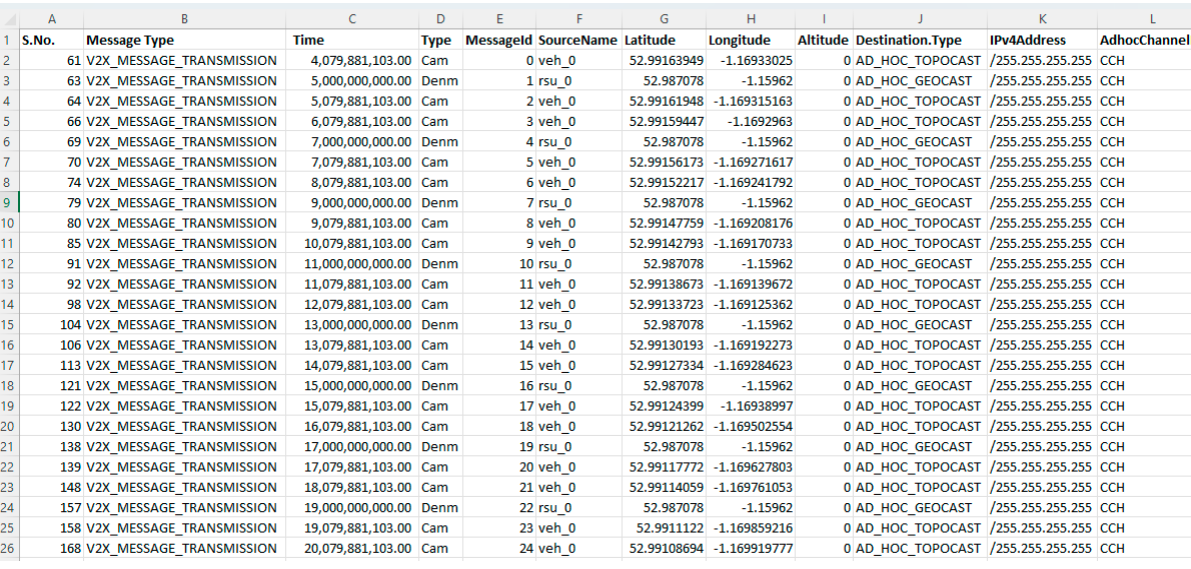
Figure 12. Message